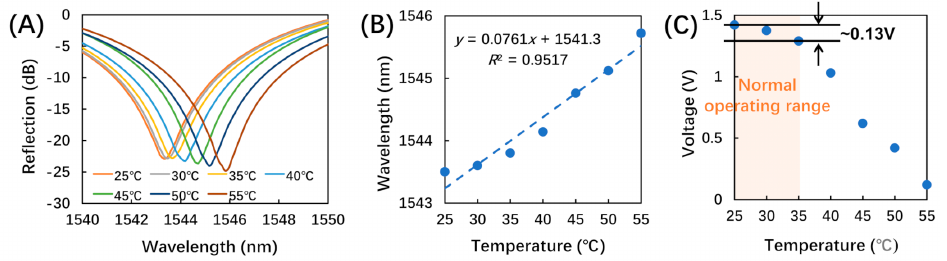
Figure 6. The temperature responses of the breath sensor. ( A ) Reflection spectra at different tempera- tures; ( B ) linear fitting of the dip wavelength ( ∼ 1545 nm) as a function of temperature; ( C ) amplitude of the reflected light under normal operating